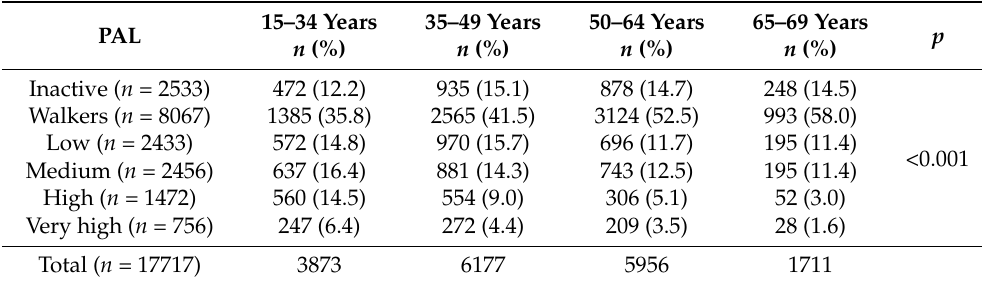
Table 2. Association between physical activity level and age group in the Spanish population through the ENSE 2017.